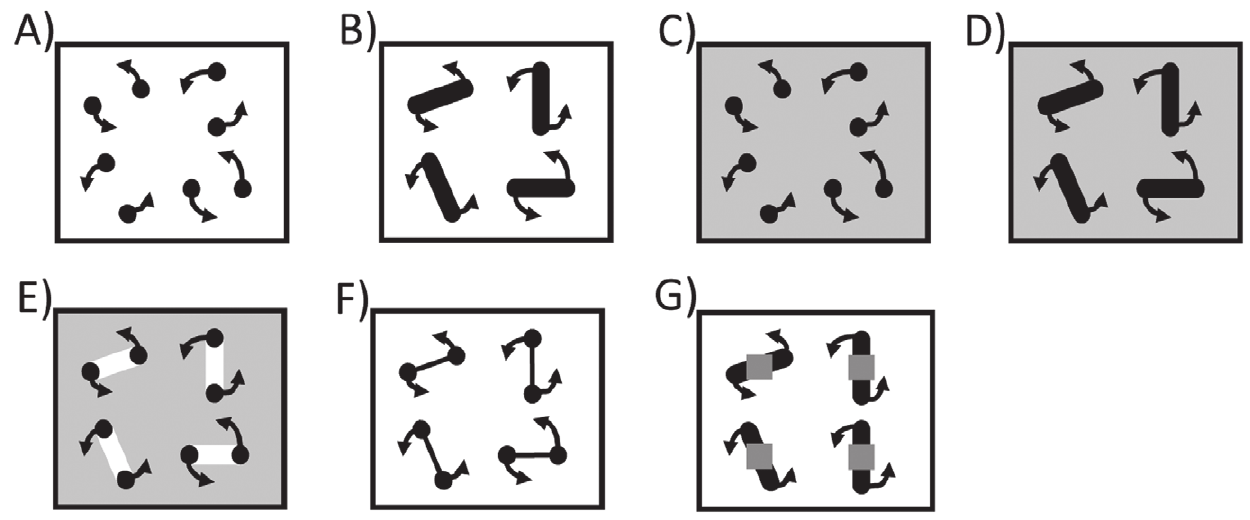
Figure 2. Cartoons of the seven stimuli used in our experiments.